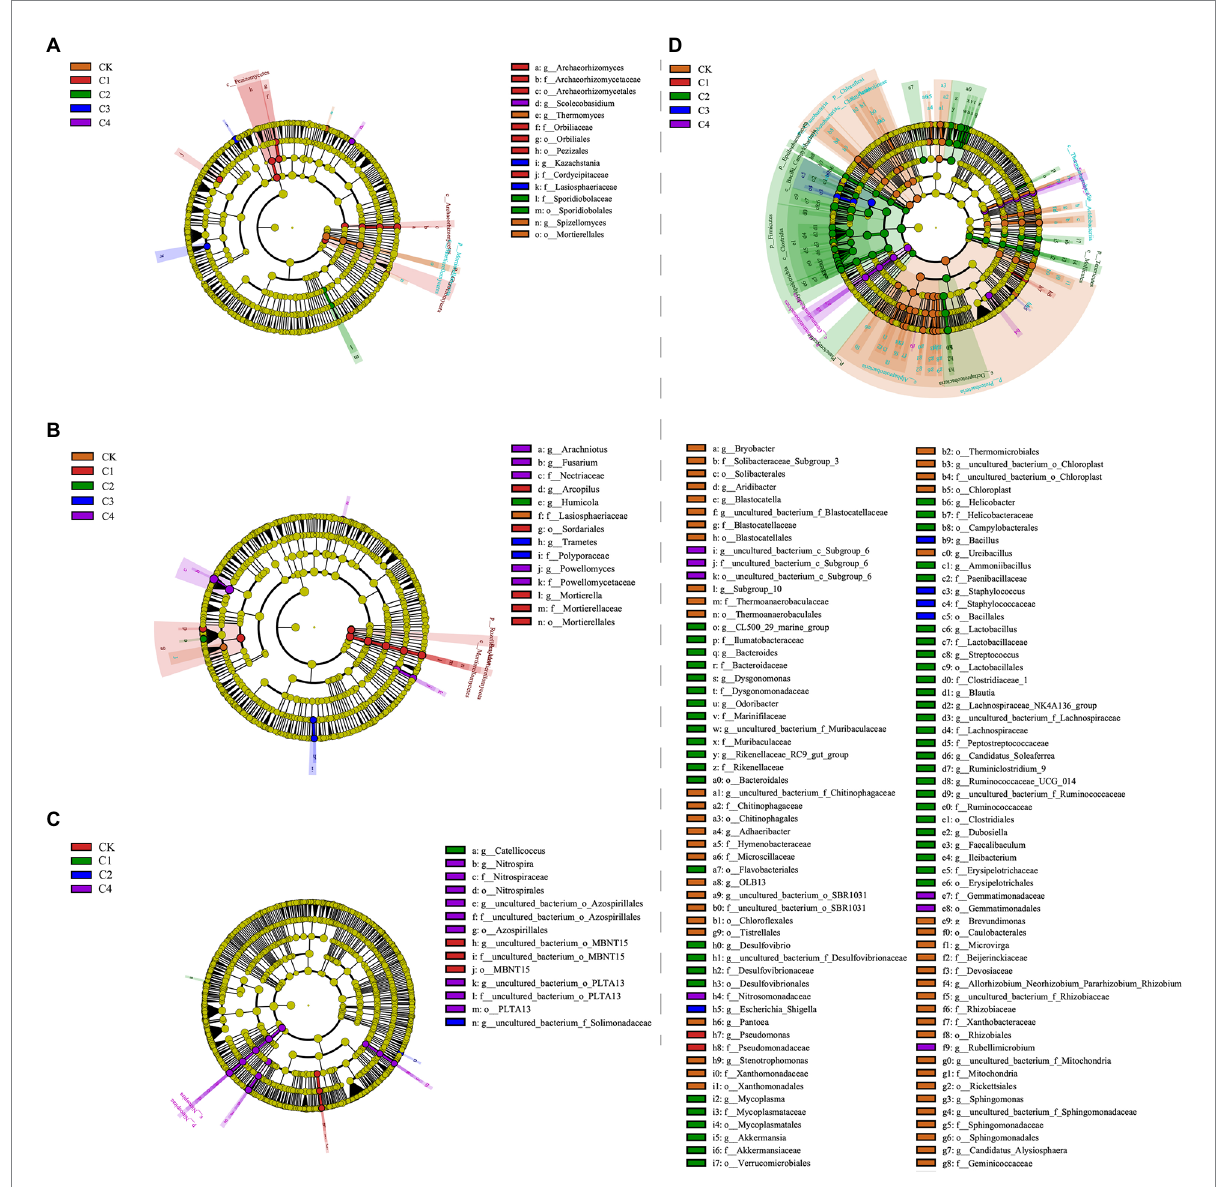
FIGURE 5 Analysis of the effect of biochar addition on soil microbial communities at the phylum and genus level using Linear discriminant analysis (LDA) effect size (LEfSe). (A) Fungal communities in bulk soil. (B) Fungal communities in rhizosphere soil. (C) Bacterial communities in bulk soil. (D) Bacterial communities in rhizosphere